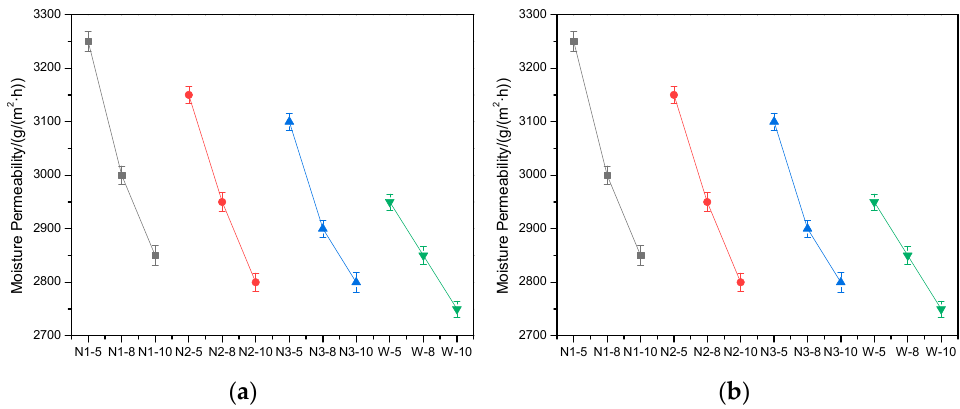
Figure 3. Moisture permeability of composite wadding: ( a ) positive side and ( b ) opposite side.